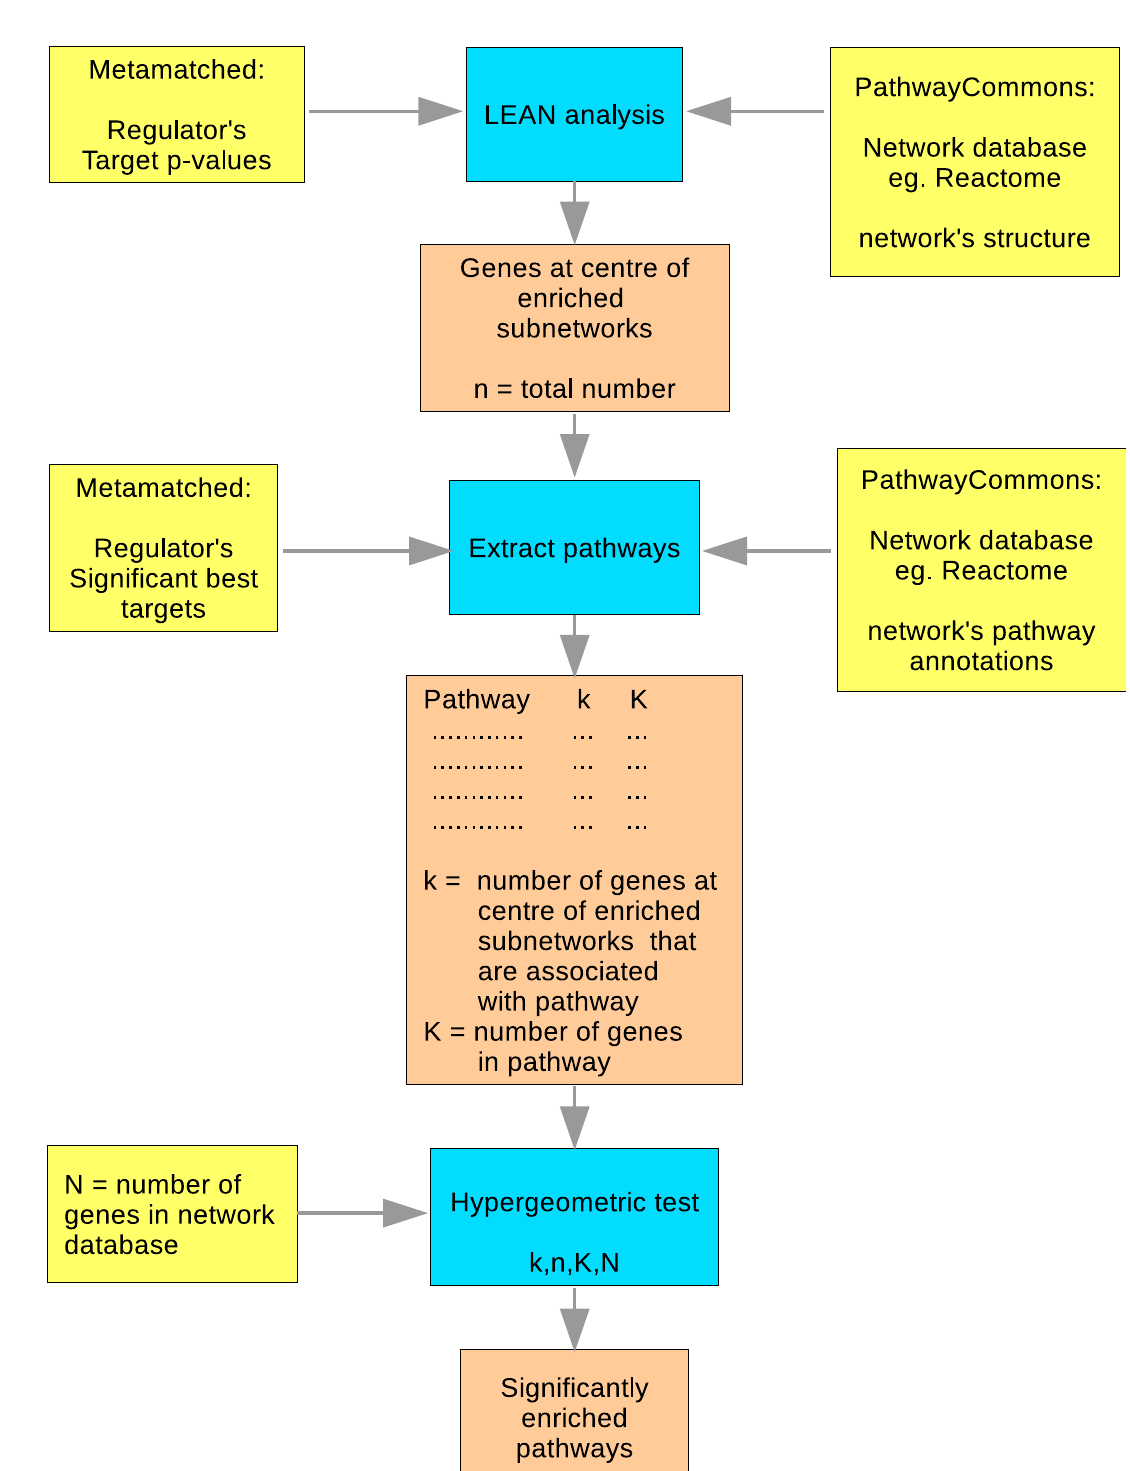
PLOS ONE | https://doi.org/10.1371/journal.pone.0213221 July 23,